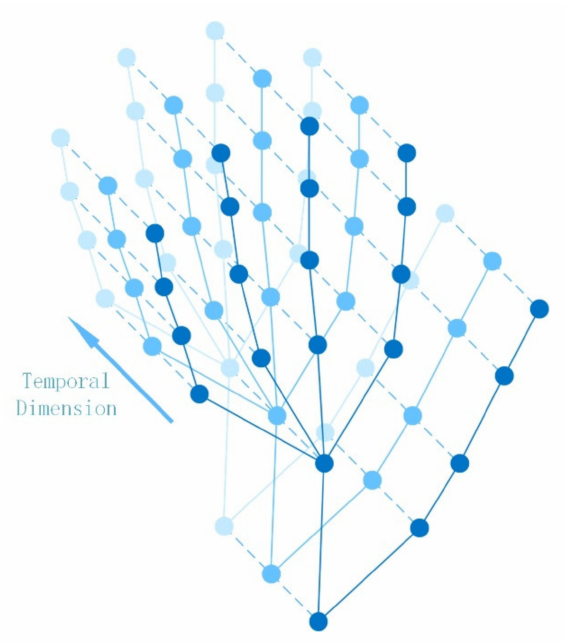
Figure 2. Skeleton spatial–temporal